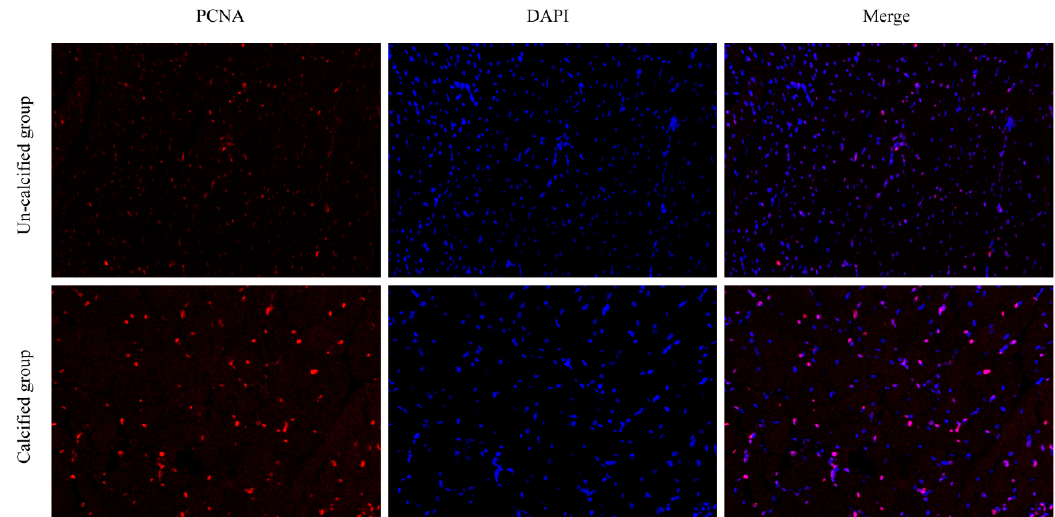
Figure 3. Immunofluorescence staining for Proliferating Cell Nuclear Antigen (PCNA) expression in the development of duck pectoral muscle.